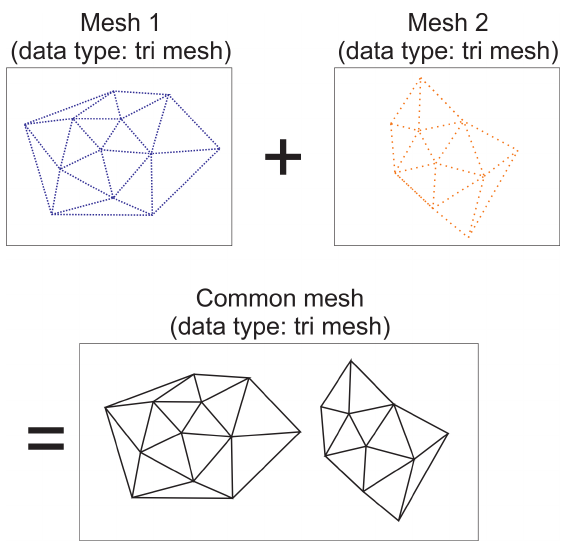
Figure 8. Multiple bodies’ triangle meshes are internally handled like a single mesh, thus allowing for easy implementation of mutual illumination or shadowing as well self-illumination (diffuse) e.g., in crater walls.